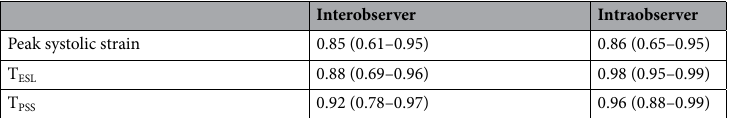
Table 4. Intraclass correlation coefficients (95% confidence intervals) in interobserver and intraobserver measurements for peak systolic strain, T ESL , and T PSS in the apical anterior segment.